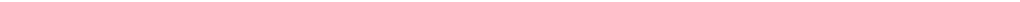
TABLE 3 | Firm performance. This table presents the results of fi rm performance using DID estimations. Firm performance consists of four variables to track fi rm ’ s development capability, leverage condition, pro fi tability, and fi nancial distress status. The interaction between HP Firms and After is used to measure the impacts of the two revisions of the environmental protection fee. For the probit regression (column Distress), we report the marginal effect rather than the coef fi cients. For the de fi nitions of variables refer to Appendix A . P -values are in